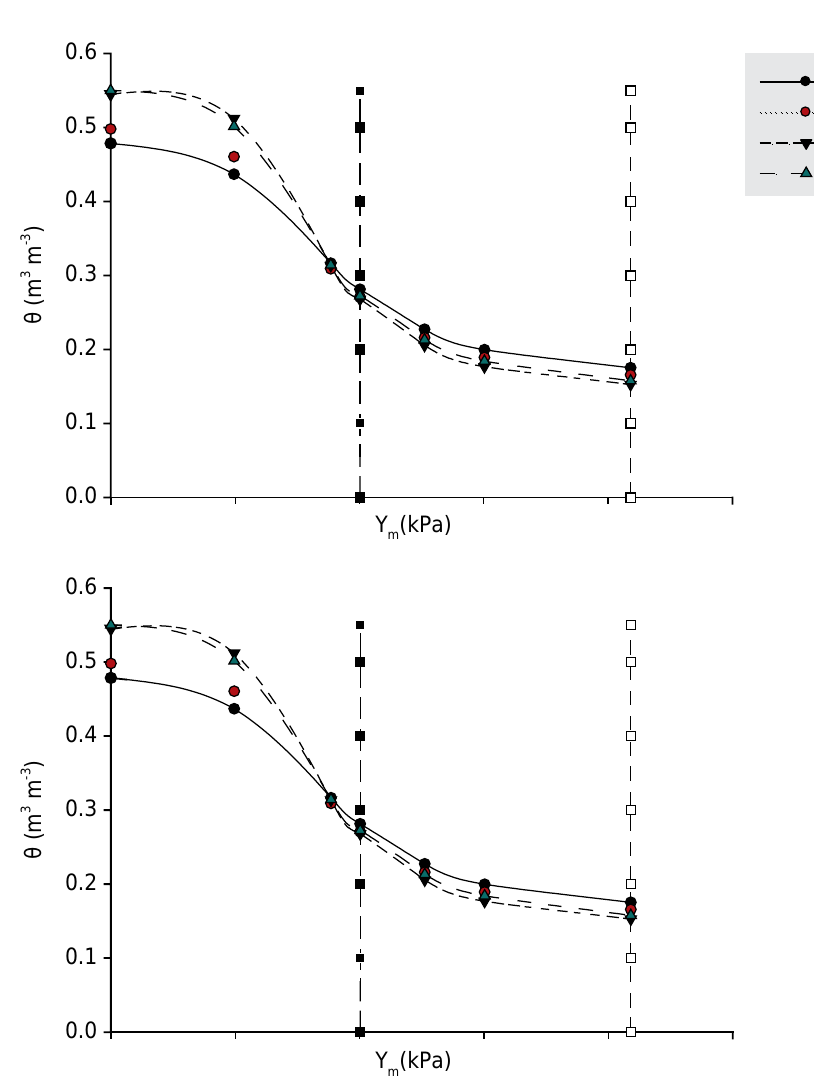
Figure 4. Water retention curves adjusted using the van Genutchen model of a Typic Hapludult under different rates of rice husk ash in the 0.00-0.10 (a) and 0.10-0.20 m (b) layers. The vertical dotted lines indicated the θ CC (soil water content at field capacity, 10 kPa) and θ PWP (soil water content at wilting point, 1,500 kPa).